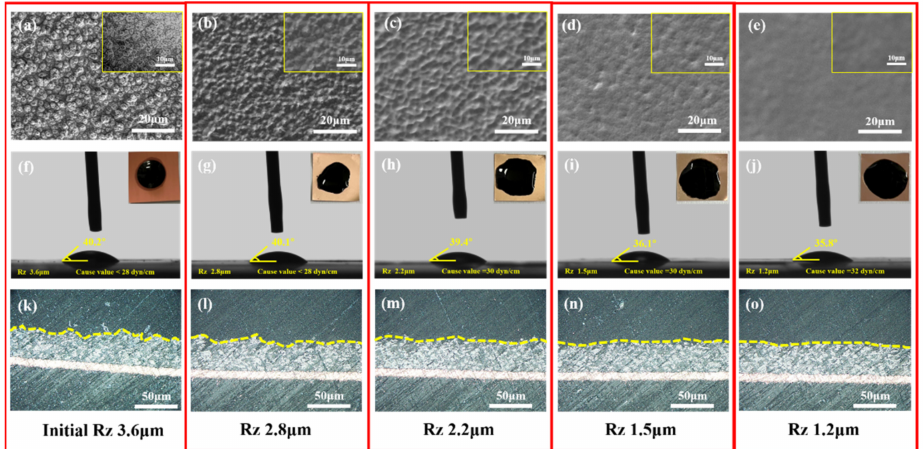
Figure 2. SEM images for electrolytic copper foils with different roughness (Rz) values: ( a ) CF- 3.6, ( b ) CF-2.8, ( c ) CF-2.2, ( d ) CF-1.5, ( e ) CF-1.2. Contact angles and cause values between N- Methylpyrrolidone and electrolytic copper foils with different roughness. The wettability of the anode slurry and electrolytic copper foil is shown in the upper right corner of the figure: ( f ) CF-3.6, ( g ) CF-2.8, ( h ) CF-2.2, ( i ) CF-1.5, ( j ) CF-1.2. Cross-section optical microscopy images of graphite anode coated on electrolytic copper foils: ( k ) CF-3.6@graphite, ( l ) CF-2.8@graphite, ( m ) CF-2.2@graphite, ( n ) CF-1.5@graphite, ( o )